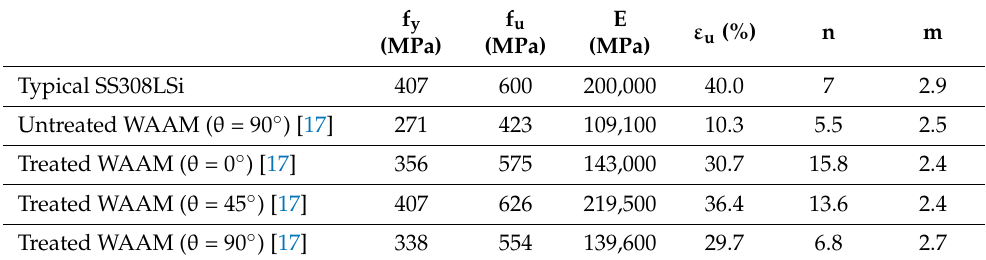
Table 1. Adopted stainless steel material properties in the study.